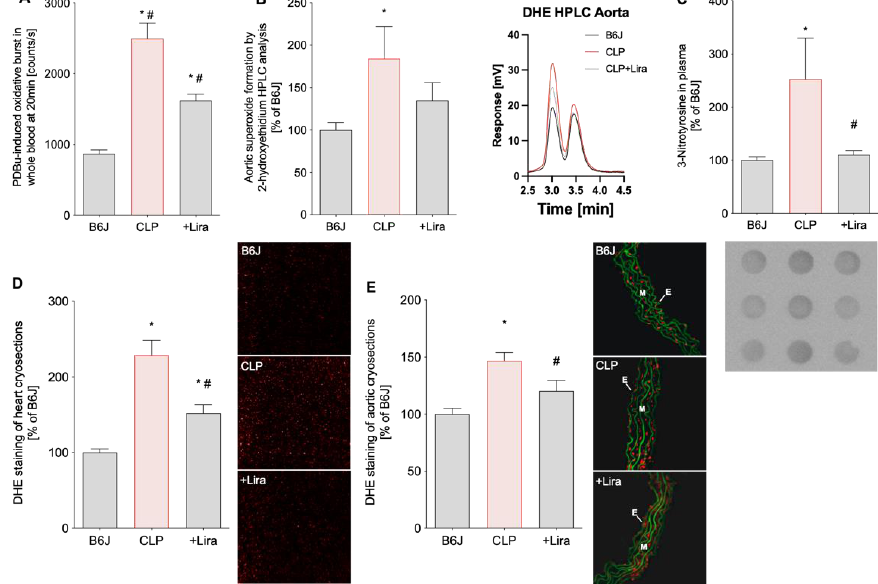
Figure 4. Treatment with the GLP-1 receptor agonist liraglutide reduces CLP-induced vascular, car- diac and systemic oxidative stress in polymicrobial septic mice. ( A ) The whole blood oxidative burst was determined by chemiluminescence (L-012) after phorbol ester (PDBu) stimulation. ( B ) The su- peroxide-specific DHE product, 2-hydroxyethidium, was quantified in aortic tissue and expressed as a percentage of B6J controls. Representative chromatograms are shown besides the quantification. ( C ) 3-nitrotyrosine (3-NT)-positive proteins in plasma as a consequence of peroxynitrite formation were measured by dot blot analysis. A representative image is shown below the densitometric quan- tification. ( D , E ) Cardiac and aortic cryosections were stained with dihydroethidium to visualize ROS formation as red fluorescence and autofluorescence from aortic laminae as green. The repre- sentative photomicrographs are shown next to the densitometric analysis. E, endothelium; M, me- dia. Data are the mean ± SEM of 6 individual blood samples (each pooled from 3 to 4 mice) ( A ), 6-8 ( B ) and 4 ( D , E ) measurements from individual animals or 4 individual plasma samples (each pooled from 3 to 4 mice) ( C ). * p < 0.05 vs. B6J; # p < 0.05 vs. CLP.